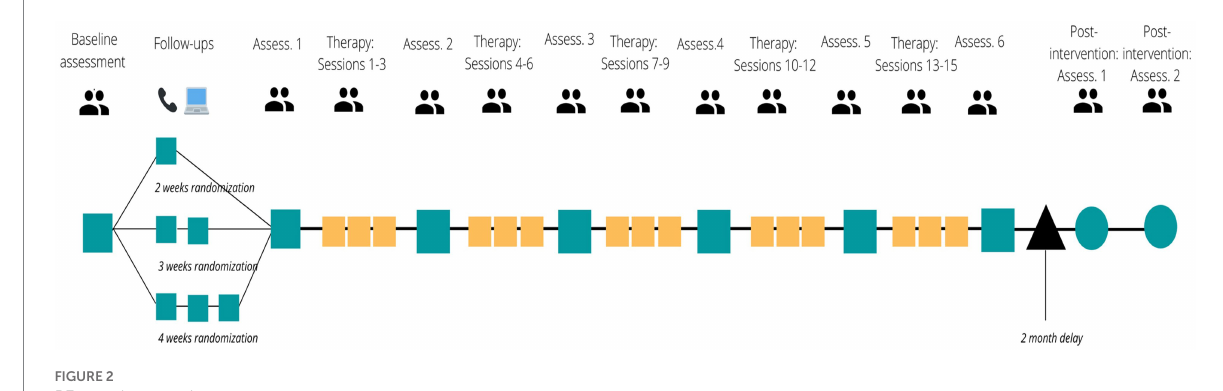
FIGURE 2 PE+ study